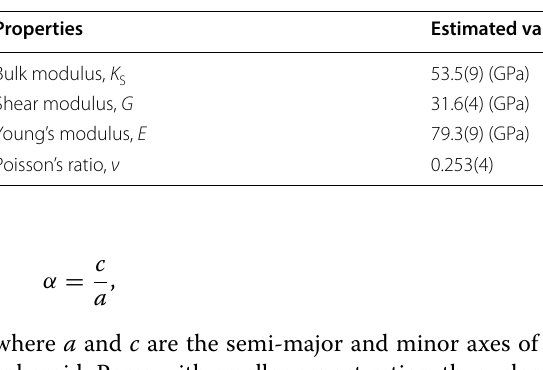
Table 2 Elastic properties of the solid phase